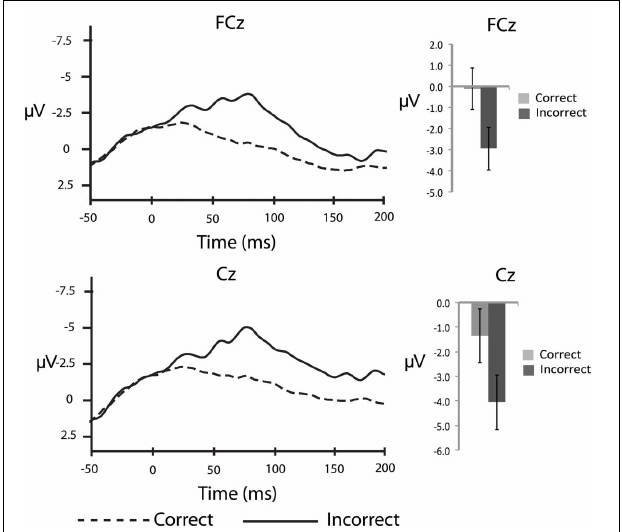
FIGURE 2 | Response-locked, grand averaged waveforms for fronto-central electrode sites: FCz and Cz. Figure shows the average waveform for correct (dashed line) and incorrect (solid line) responses (panels on the left side). The ERN can be observed after the response, peaking at ∼ 75ms post-error response. The panels on the right side show the averaged amplitudes within the 50–100ms post-response interval, with standard error